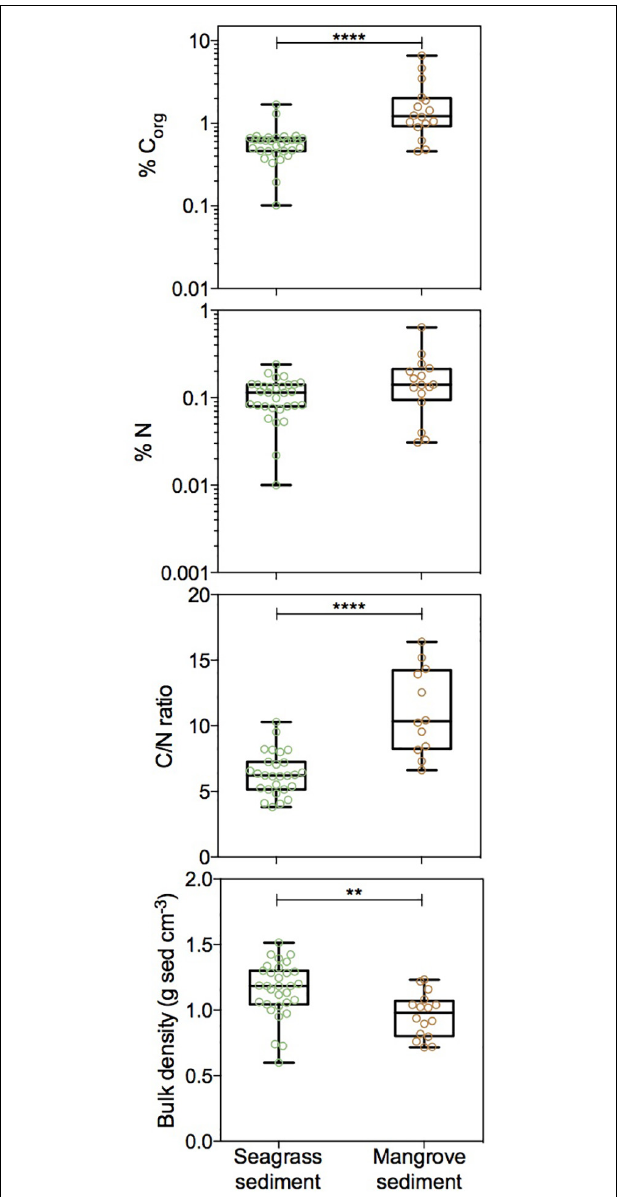
FIGURE 2 | Box plots of C org concentration, N concentration, C/N ratio, and bulk density for seagrass (green) and mangrove (brown) sediments showing all data points. Boxes extend from the 25 th to 75 th percentiles, lines inside boxes represent median values, and whiskers span from minimum to maximum values. Statistically significant differences are indicated by asterisks where ∗∗ indicates p < 0.01 and ∗∗∗∗ indicates p <